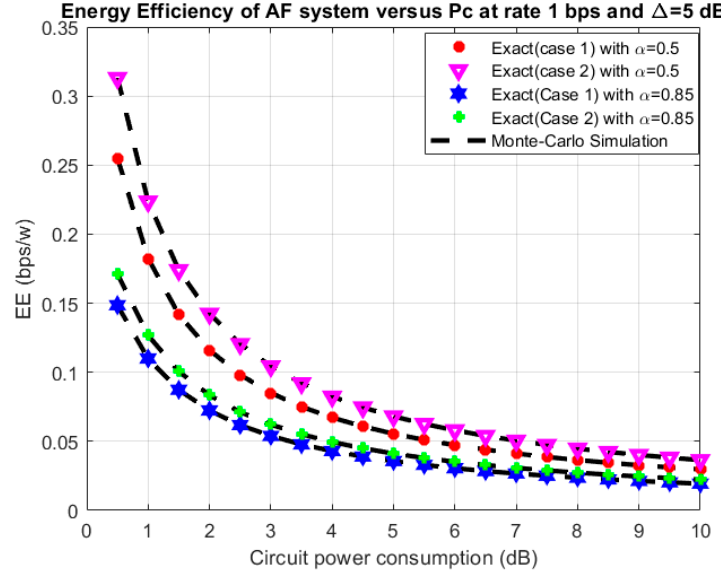
Figure 8. Energy efficiency (EE) versus α .